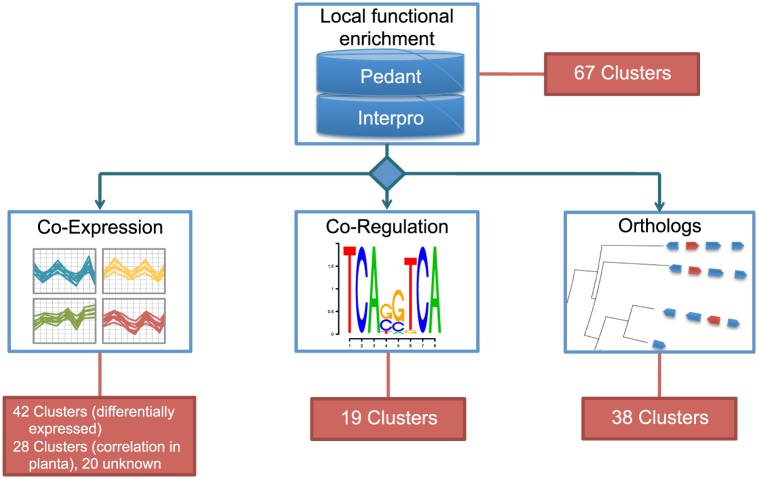
Workflow for the prediction of gene clusters in F. graminearum.Based on the gene functions found in known fungal gene clusters, 67 gene clusters with specific collections of gene functions were identified by screening the F. graminearum scaffolds. Expression data analysis resulted in 43 clusters that are either differentially expressed in at least one condition or show correlation in expression profiles during plant infection. Conserved promoter motifs could be computed in 19 clusters. 38 Clusters have orthologs in organisms outside the Fusarium clade.